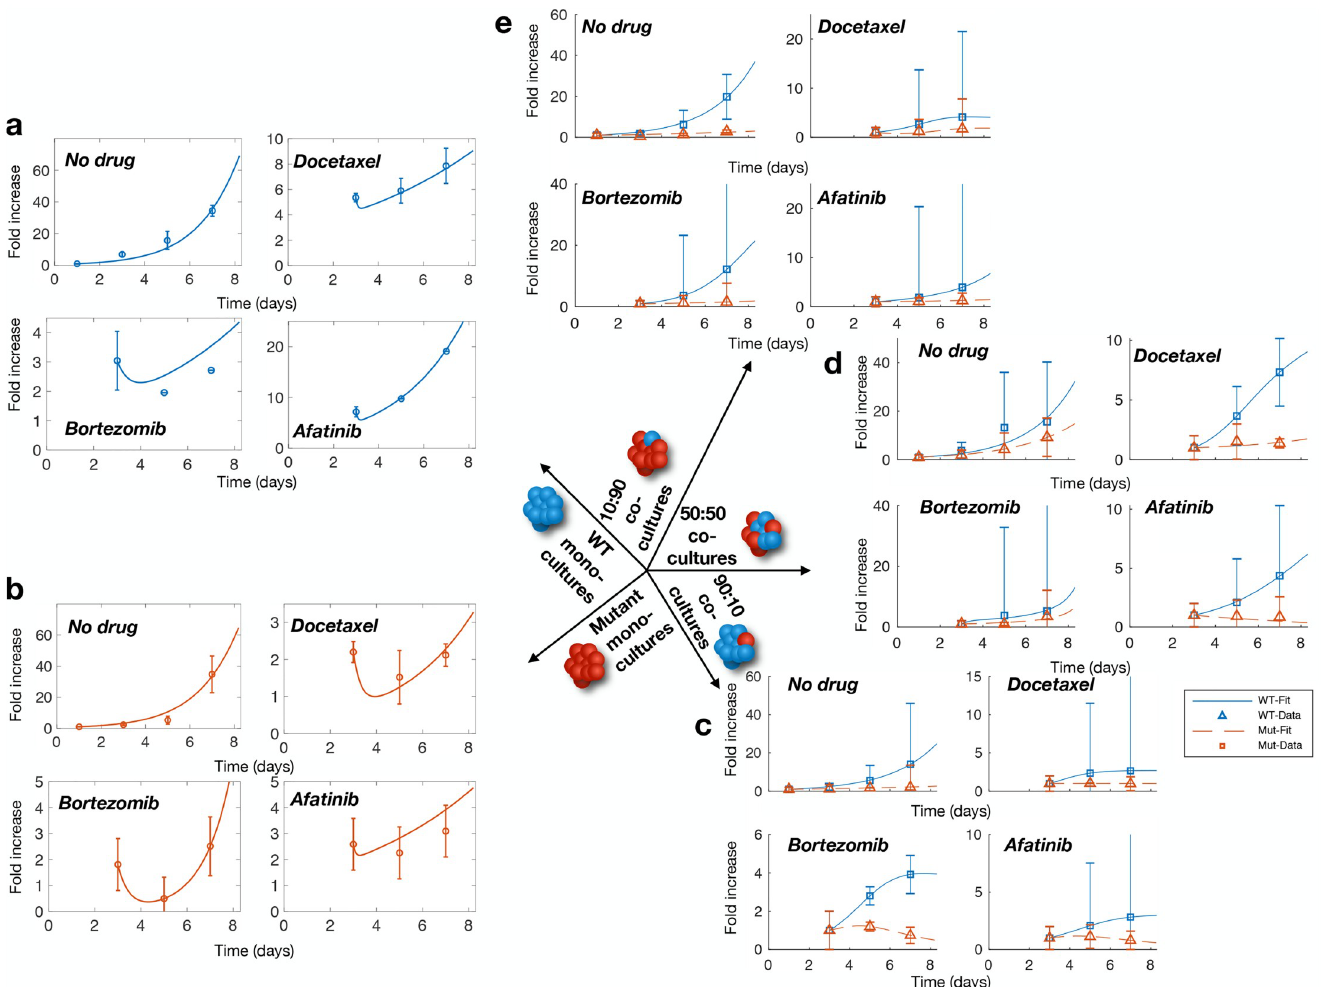
Fig 4. Population dynamics in mono- and co-cultures. a) WT monocultures growth without drug pressure, in docetaxel, in afatinib, and bortezomib (from top left to bottom left). b) M1 monoculture growth without drug pressure, in docetaxel, in afatinib, and bortezomib (from top left to bottom left). c) M1 90:10 growth without drug pressure, in docetaxel, in afatinib, and bortezomib (from top left to bottom left). d) M1 50:50 growth without drug pressure, in docetaxel, in afatinib, and bortezomib (from top left to bottom left). e) M1 10:90 growth without drug pressure, in docetaxel, in afatinib, and bortezomib (from top left to bottom left). Error bars represent normalized standard deviation of experimental data.